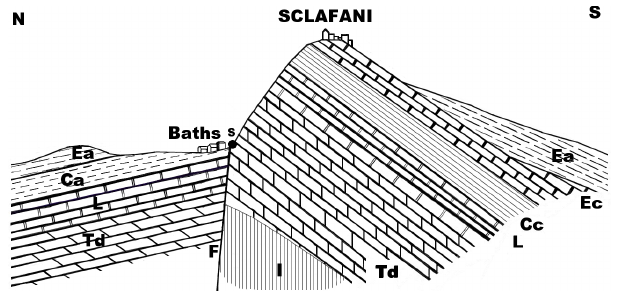
Figure 8. N–S geological and hydrogeological sketch (not in scale) of Mt Sclafani drawn by Felice Giordano, approximately in 1860, using the Bourbon maps of 1849–1852 (drawing modified after Daubrée, 1887). Legend: I – marls (Trias, Impermeable, not out- cropping); Td – Dolomites (Trias); L – Limestones (Lias); Ca – clays (Cenomanian); Cc – Marls and limestones (upper Creta- ceous); Ec – Limestones (lower Eocene); Ea – Speckled clays (mid- dle Eocene); F – Fault; S – Thermal springs and location of the an- cient Sclafani spa.